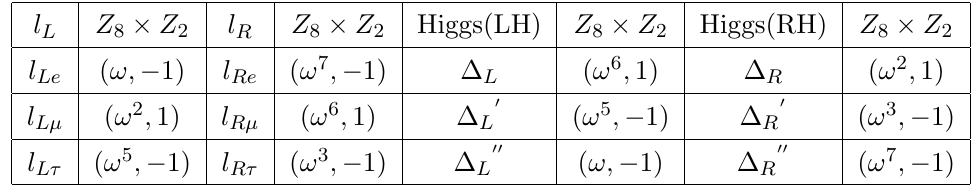
Table 3 . Particle assignments for